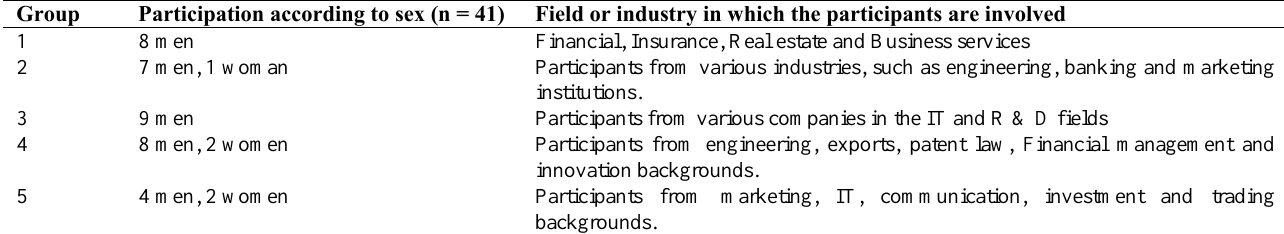
Table 1: Profile of the focus group participants Group Participation according to sex (n =